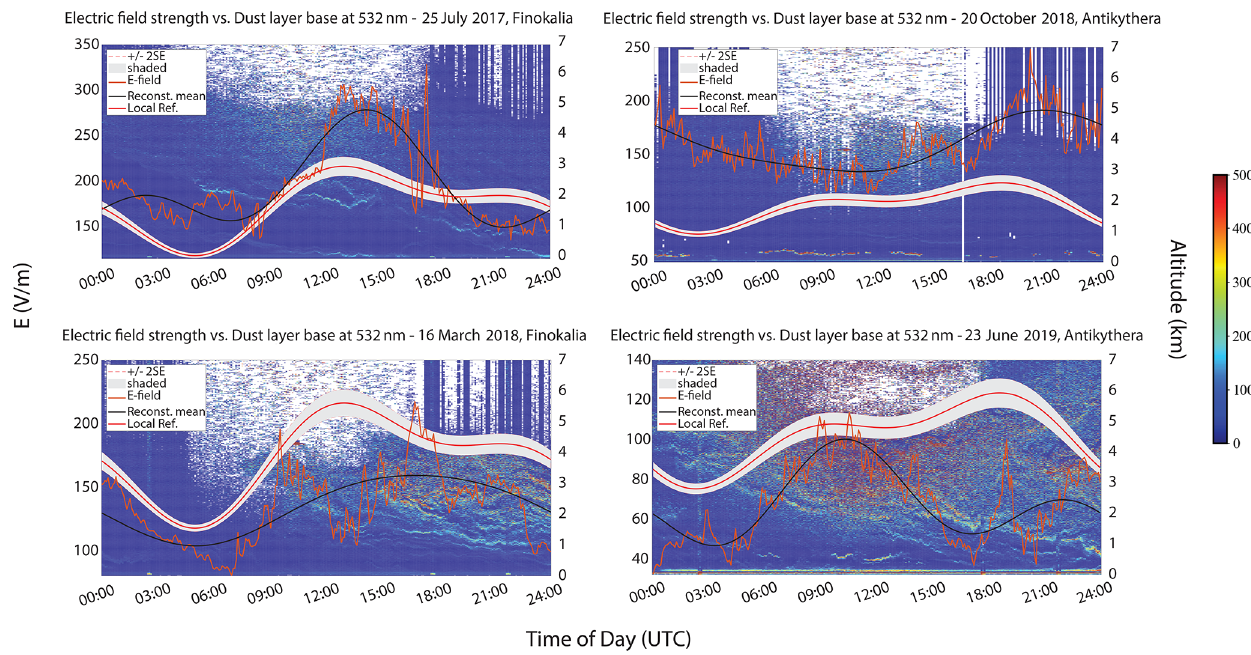
Figure 11. Time series of the vertical electric field strength (orange), the extracted localized reference (ref.) electric field (red) and the reconstructed (reconstr.) mean field variation (black), plotted with the first derivative of the cross component of the Polly XT -attenuated backscatter coefficient at 532nm against the altitude, for the dust cases of 25 July 2017, 20 October 2018, 16 April 2018 and 23 June 2019. The dust layer bottom base is signified by the positive maximum values of the derivative within the 0–500 colour bar